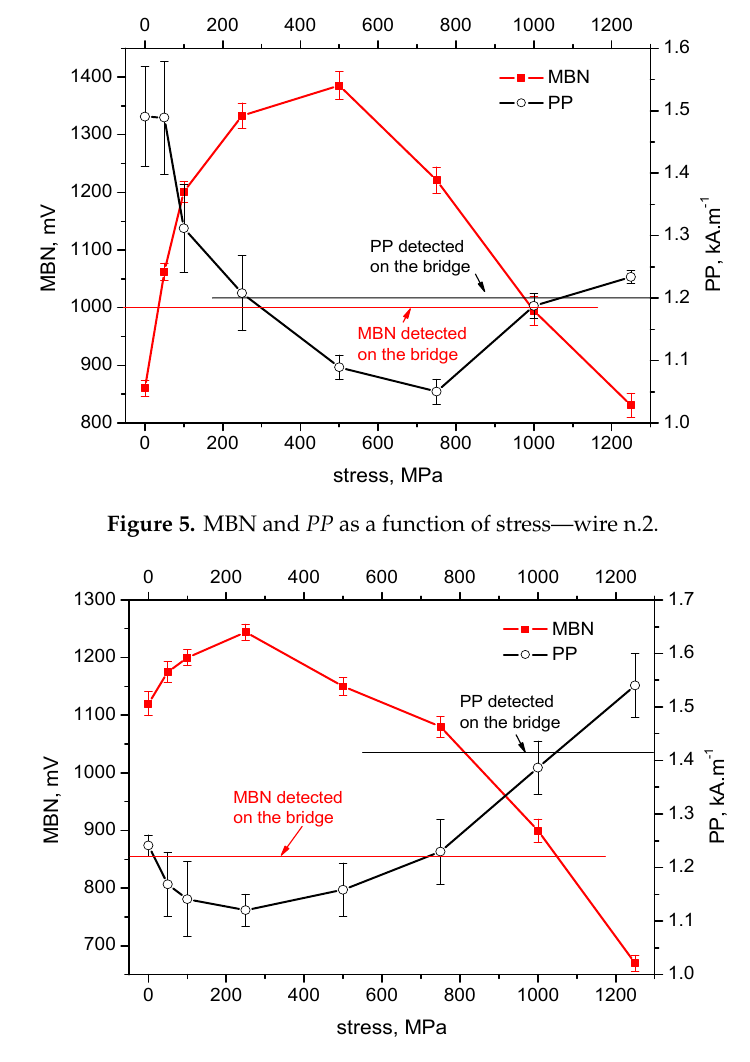
Figure 6. MBN and PP as a function of stress—wire n.3.